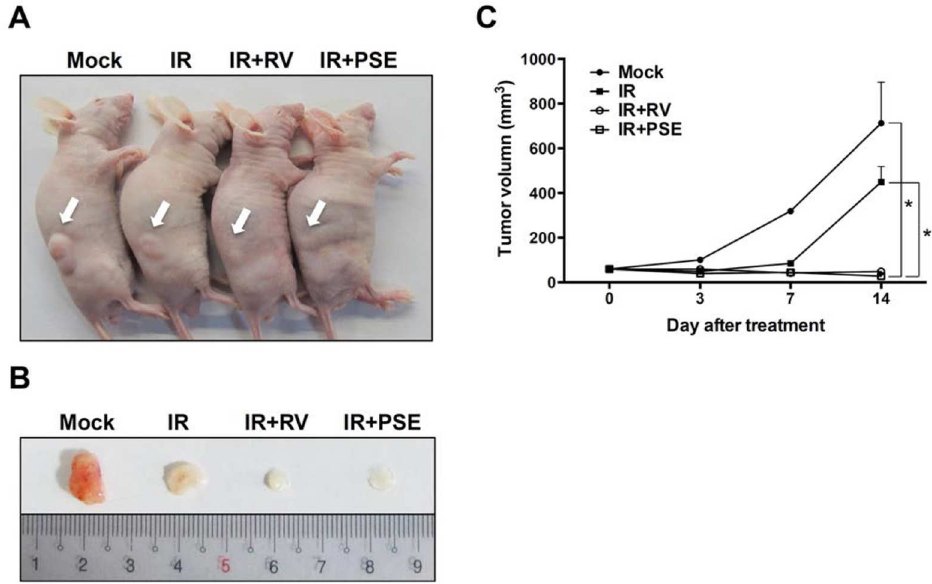
Fig 6. Resveratrol (RV) and peanut stem extract(PSE) significantly enhance irradiation (IR)- suppression of prostate cancer growth in vivo . (A) Mice with xenograft tumors were dividedinto four groupsand were treated with vehicle(mock, control) or IR alone or combinedwith RV or PSE (5 or 250 mg/kg, respectively). Arrows indicatedtumor that was grown in the posterior flanks of mice. (B) Treatments were administered on day 0, 3, 7, and 14. After euthanasia, tumors were excised from mice. Scales shown in images are in centimeter. (C) Tumor volume was calculated, and data are means ± standarddeviations; * , P < 0.01 comparedto each group.